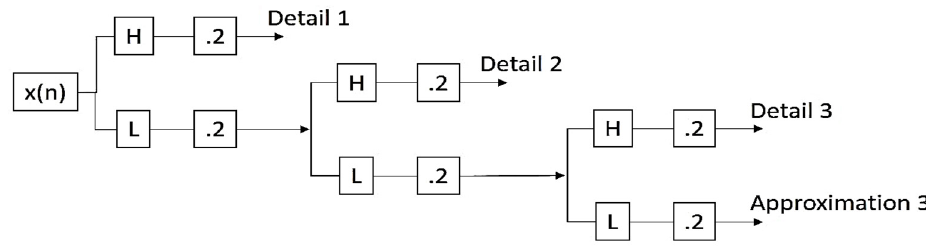
Figure 3. Multiresolution analysis.